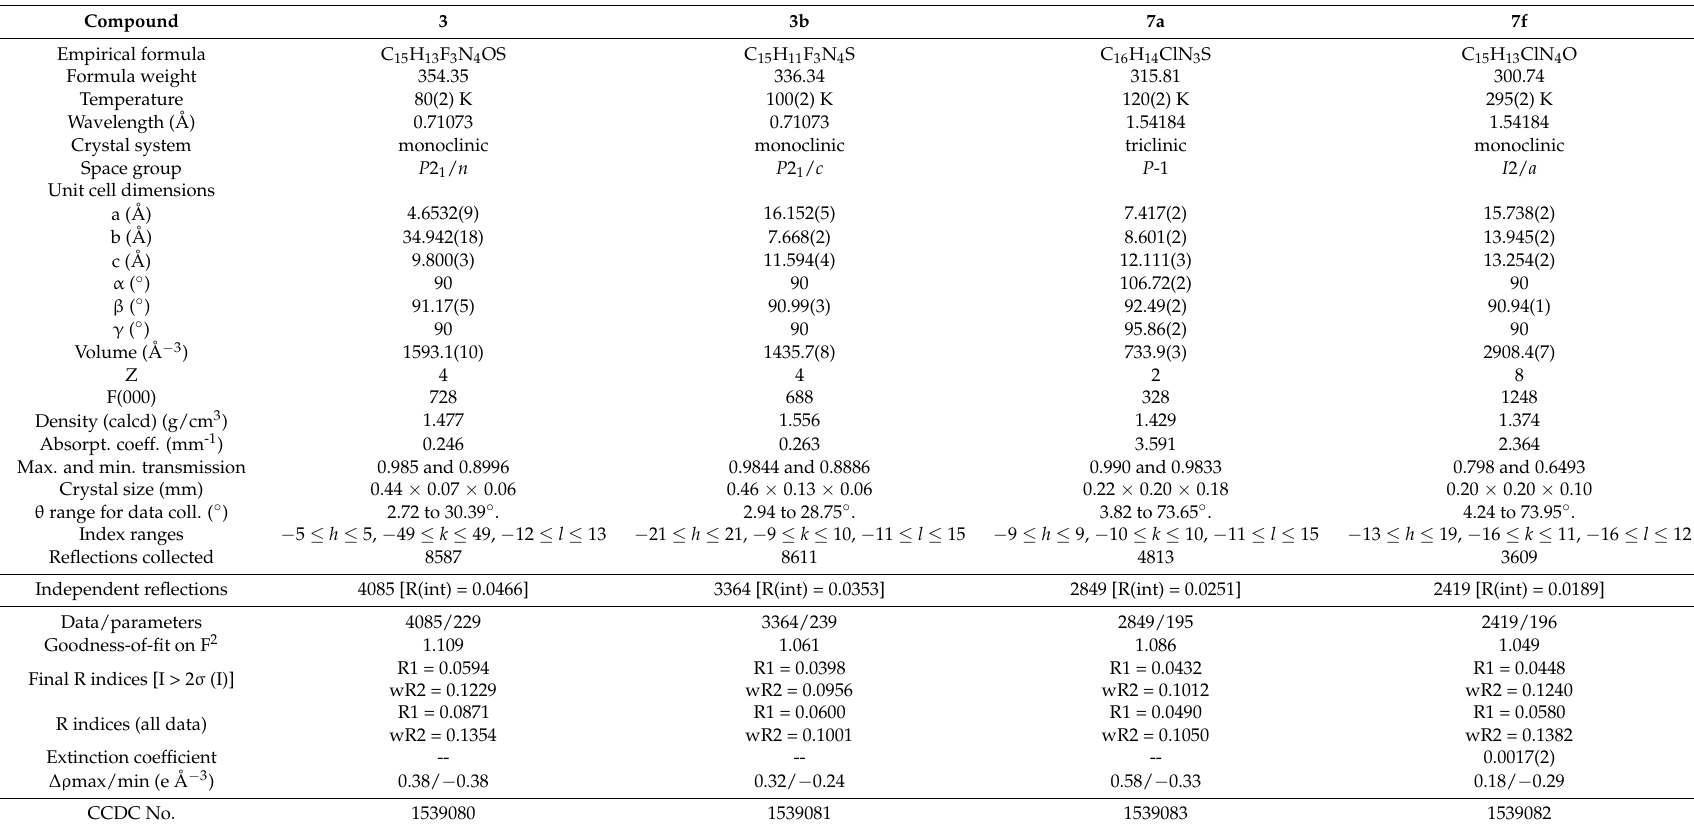
Table 1. Crystal data and structure refinement parameters for 3 , 3b , 7a and 7f